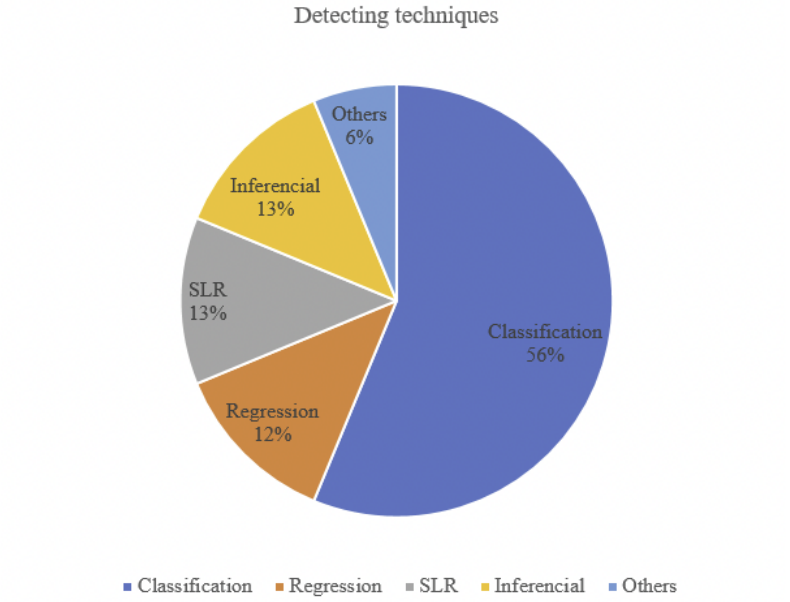
Figure 5. Detecting techniques and other techniques used in the